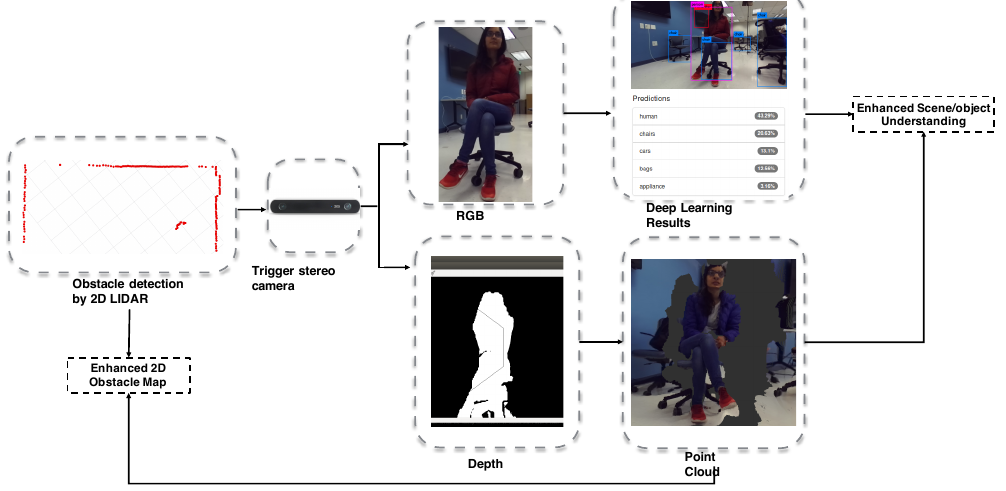
Figure 6. The hyrid obstacle detection